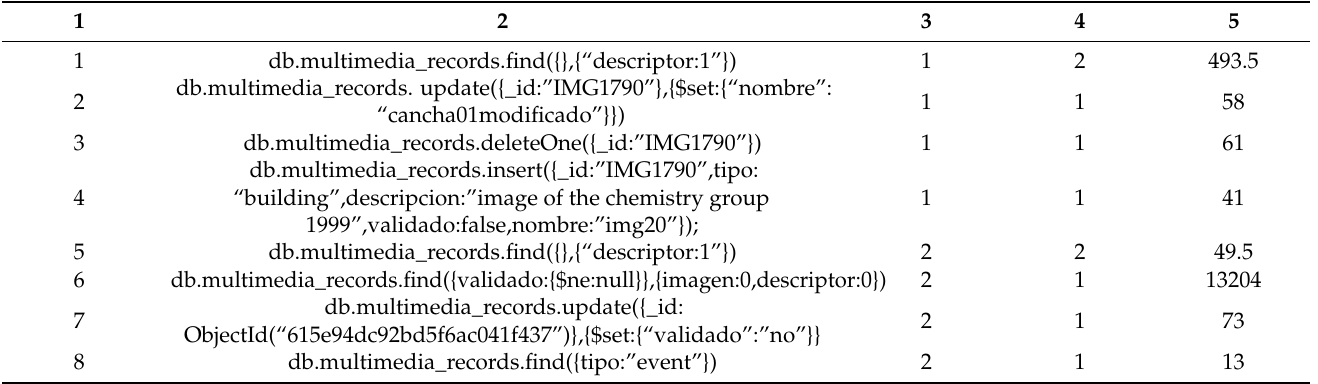
Table 9. Operations performed on the centralized multimedia database under a new workload.